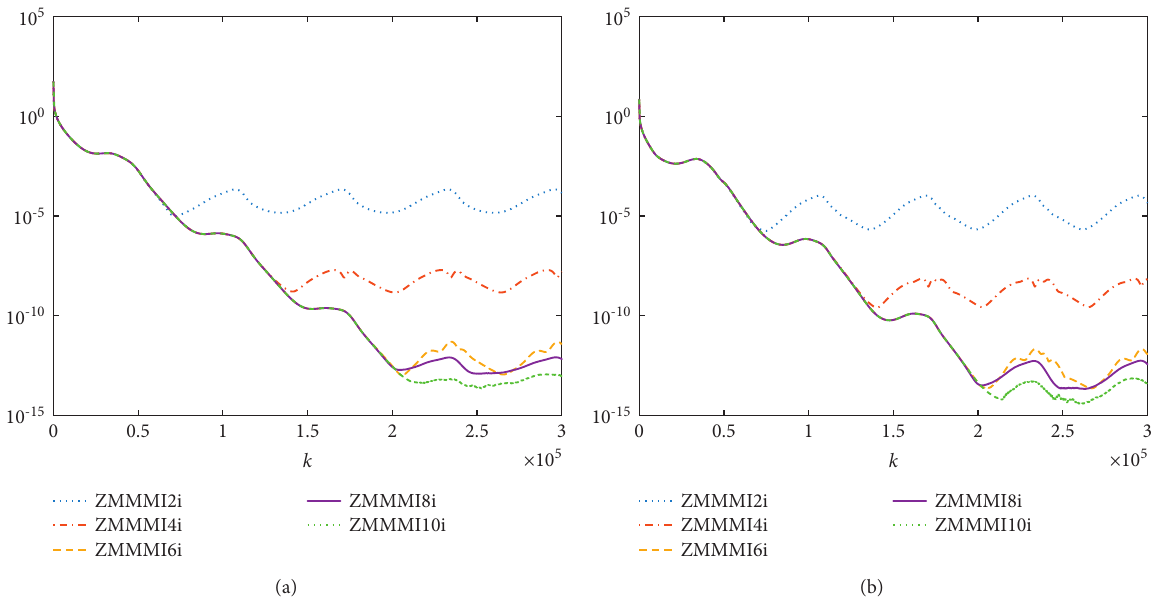
Figure 13: Residual error trajectories synthesized by five ZMMMI algorithms for example 3 (with ϵ � 0 . 0001 s and c � 2 . 0). (a) Trajectories A − I ‖ . (b) Trajectories of ‖ X k + of ‖ X k + k + 1 1 F